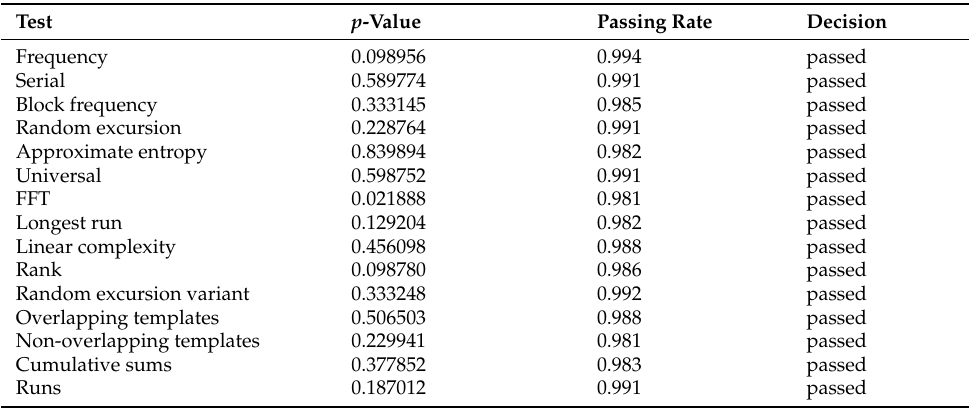
Table 4. NIST statistical tests results.